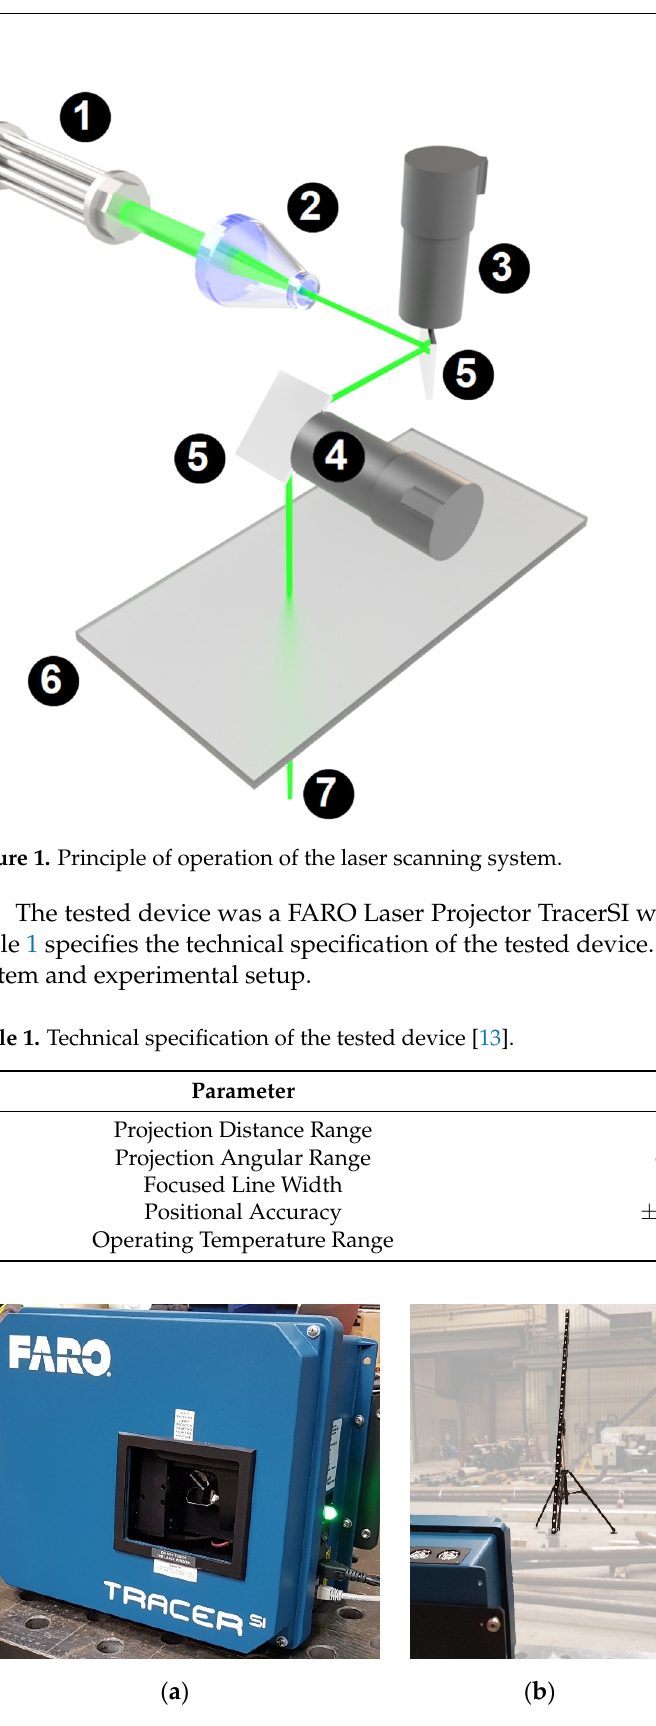
Figure 2. The tested system: ( a ) galvanometer Scanning System and ( b ) experimental setup. Table 1. Technical specification of the tested device [13].